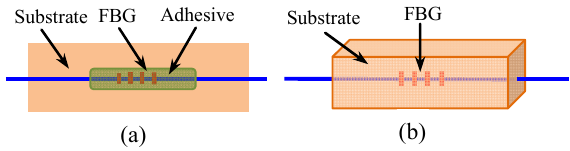
Fig. 3 Full package structure diagram of fiber optic grating: (a) fixed on the substrate surface and (b) embedded in the